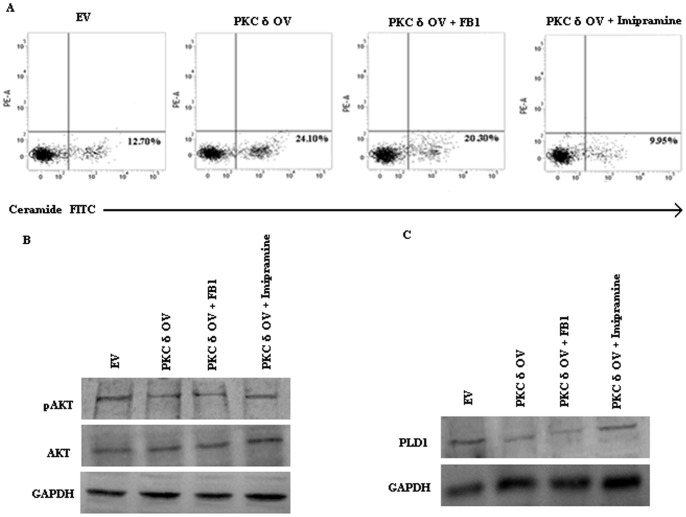
Regulatory effect of PKCδ and PLD1 on aSMase mediated ceramide generation.(A) B16F10 cells overexpressing full-length mouse PKCδ (PKCδOV) or empty vector (EV) were treated with Fumonisin B1(FB1) (10 uM) and Imipramine (10 uM) respectively for 1 hour. The transfected cells were washed and after 24 hour of incubation were stained with anti-mouse ceramide-FITC, isotype-matched control mouse antibody, and analyzed by flow cytometry for ceramide (FL1) expression. Representative data exhibited were from three independent experiments. (B) The transfectants of B16F10 cells overexpressing PKCδ (PKCδOV) or the empty vector (EV) were treated with FB1 (10 uM) and Imipramine (10 uM) for 1 hour. The transfected cells were washed and after 24 hours of incubation the whole cell lysates were subjected to SDS-PAGE and Western blot analysis to study the expression of pAKT and total AKT. Data represented here are from one of three independent experiments. (C) Similarly, B16F10 cells transfected with empty vector (EV) and full-length PKCδ (PKCδOV) were treated with FB1 (10 uM) and Imipramine (10 uM) as mentioned previously and expression of PLD1 was analysed by western blotting. Data represented here are from one of three independent experiments. GAPDH was used as a reference.